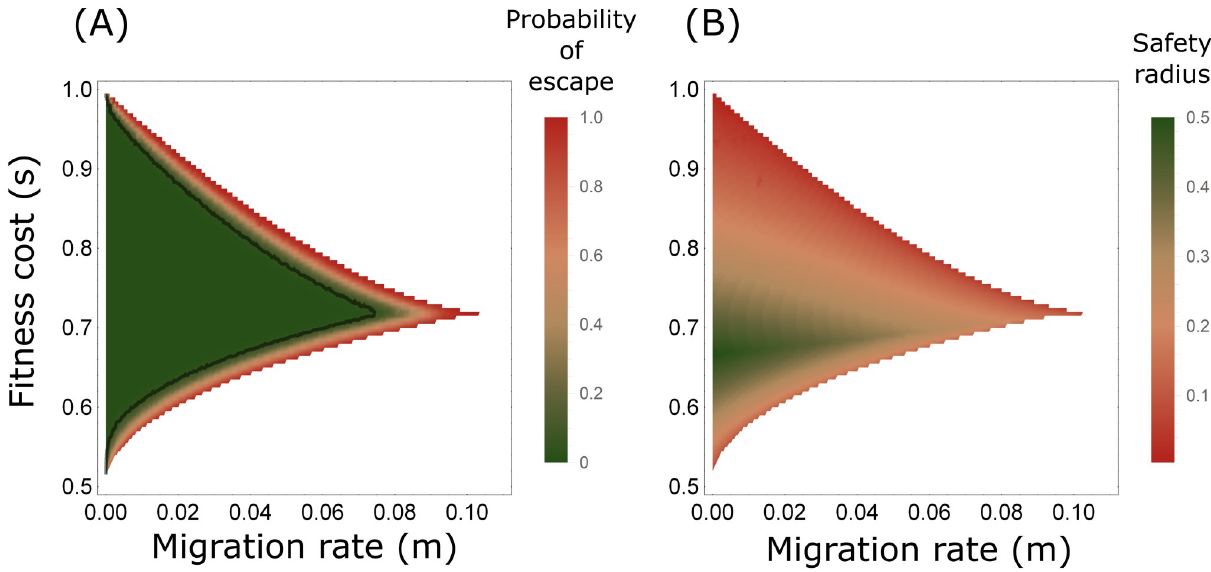
Fig 5. Perturbation from DTEs. Results shown for gene drives with full conversion, c = 1, and for different migration rates m and selection coefficients s . White regions denote scenarios for which m > m � . (A) The probability of escape from the DTE due to genetic drift, defined as the probability of departing from the attraction basin of the DTE over 100 generations with genetic drift, in a Wright-Fisher population with N e = 100. The black line denotes 5% probability of escape. Probabilities were estimated with 1000 simulated replicates. (B) The safety radius of the DTE.